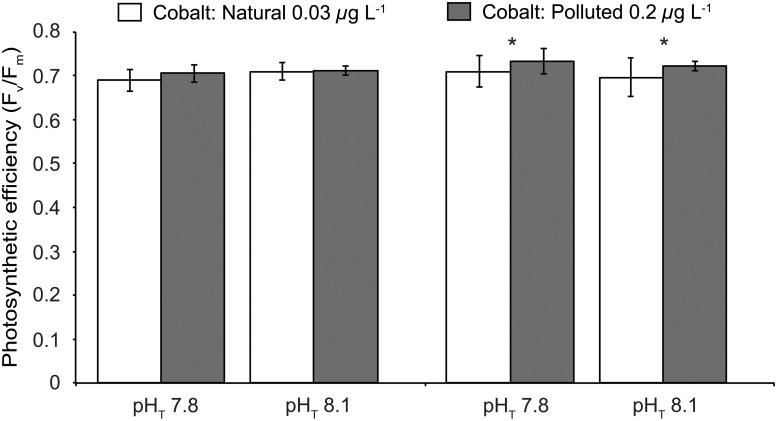
Effective photosynthetic efficiency (Fv/Fm) measured on dark adapted Stylophora pistillata and Acropora muricata colonies exposed during five weeks to two pHT conditions (pHT 7.8 or 8.1) and two cobalt concentrations (Natural and Polluted).Stars indicate statistically significant differences (Tukey’s test, p<0.05). Each point represents the mean ± SD (n = 10).